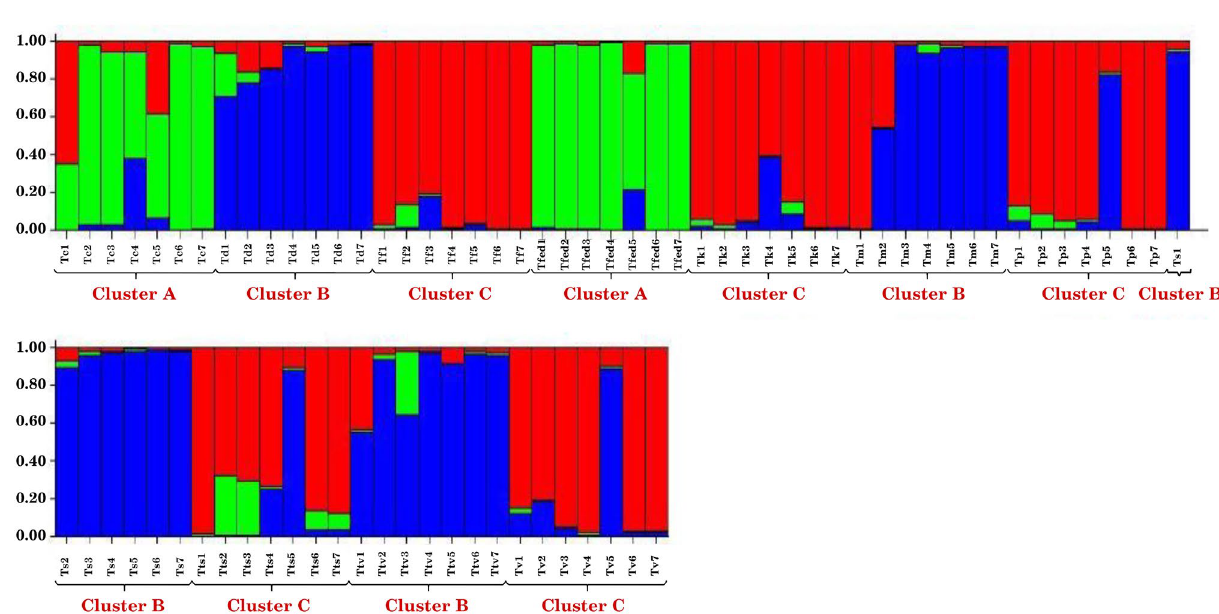
Figure 7. Genetic structure of 77 Thymus genotypes as inferred by STRU CTU RE software with eight SRAP markers data set. Single vertical line represents an individual accessions and different colors represent genetic stocks/gene pools. Segments of each vertical line show extent of admixture in an individual (for interpretation of the references to colour in the text, the reader is referred to the web version of this